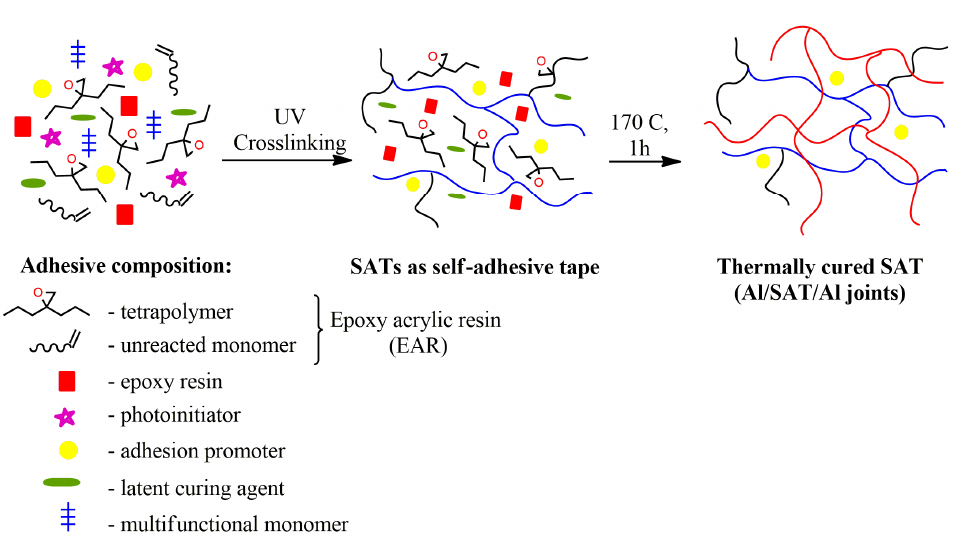
Figure 2. Preparation of SATs and Al/SAT/Al